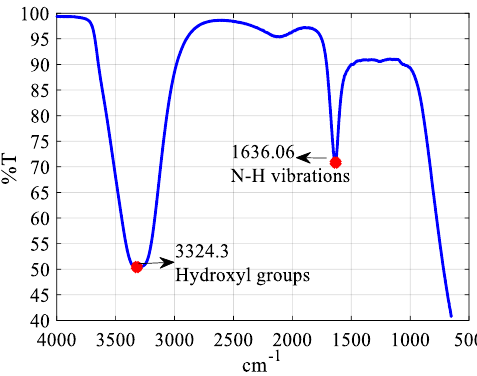
Figure 8. Fourier transform infrared (FTIR) spectrum of magnet coated with polydopamine (PDA). The peak between wavelength of 1500 – 1650 cm −1 indicates N – H vibrations, and peak between wavelength of 3200 – 3600 cm −1 indicates hydroxyl groups in the structure. This proves successful coating of magnet surface.